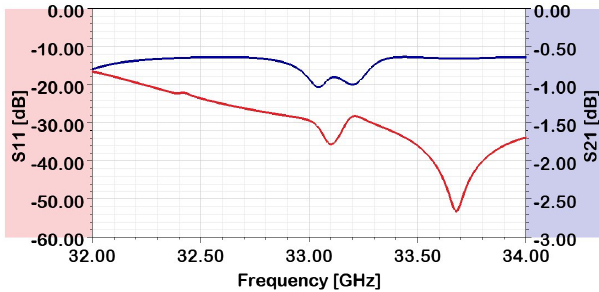
FIGURE 7. S 11 (red) and S 21 (blue) of the complete structure (32-34